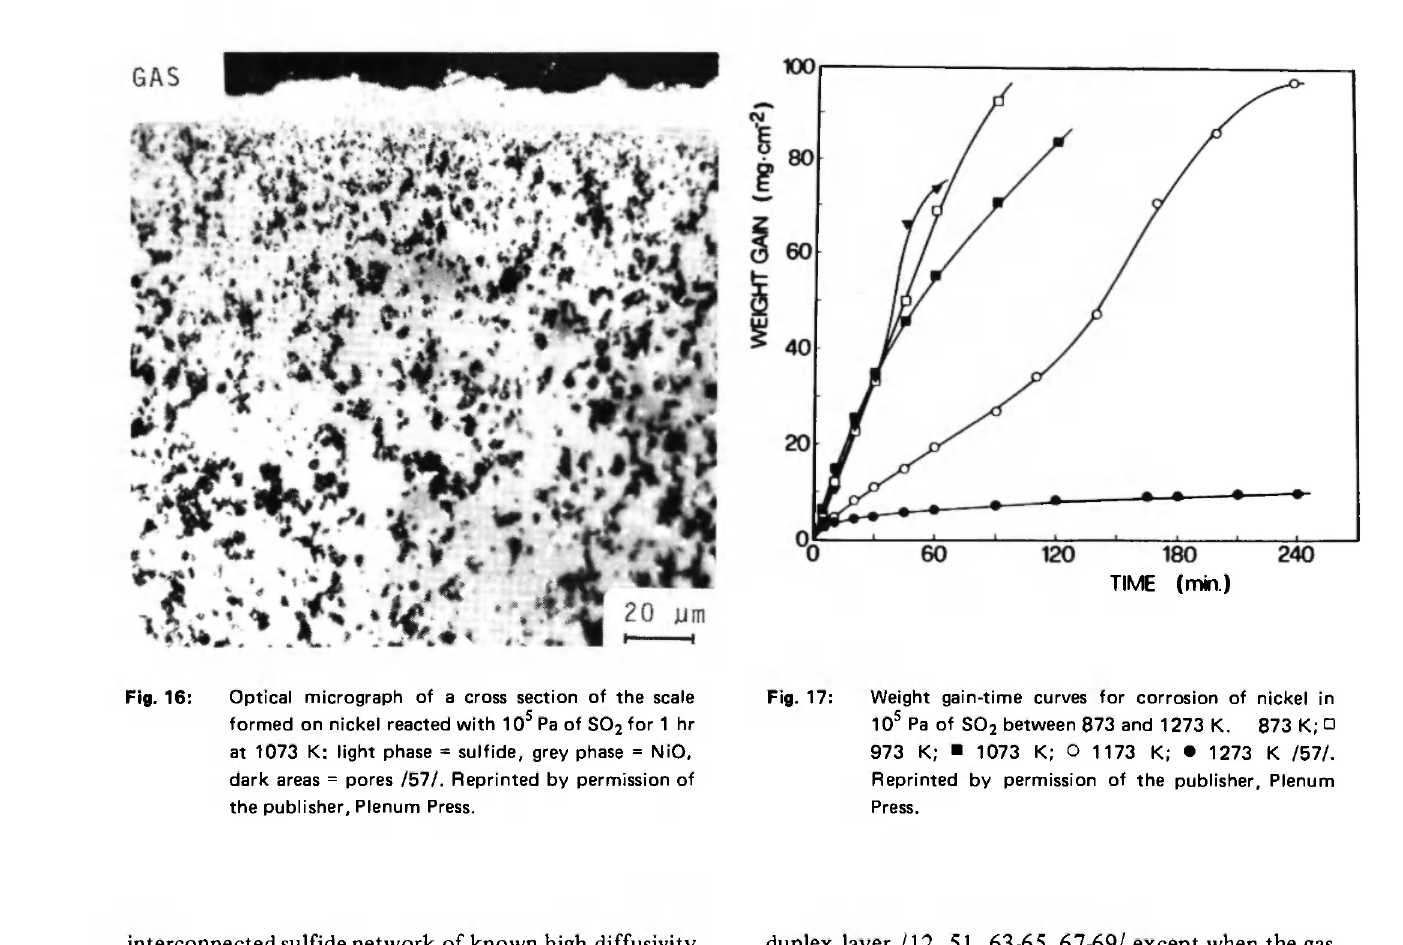
Fig. 16: Optical micrograph of a cross section of the scale formed on nickel reacted with 10 s Pa of SO2 for 1 hr at 1073 K: light phase = sulfide, grey phase = NiO, dark areas = pores /57/. Reprinted by permission of the publisher. Plenum Press.